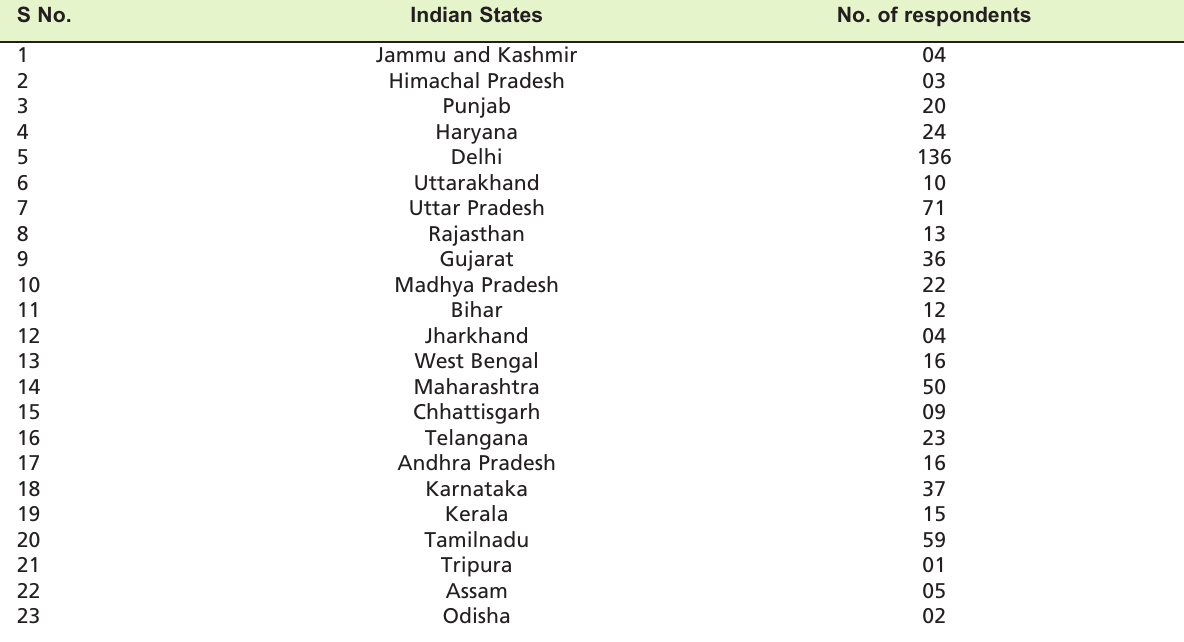
State wise distribution of respondents Table I: